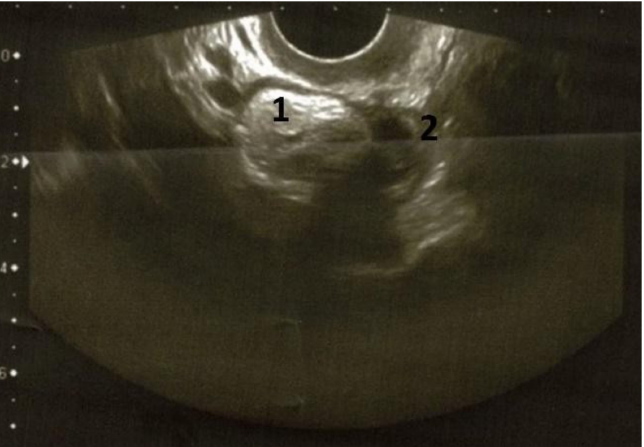
Figure 3. Transvaginal ultrasound examination (2020) of the left ovarian teratoma. The left ovary showed a solid tumor (3.5 × 3.0 × 3.4 cm) with increased echogenicity and clear smooth contour, without vascularization zones (1: tumor; 2: remaining ovarian tissue; previously unpublished, original